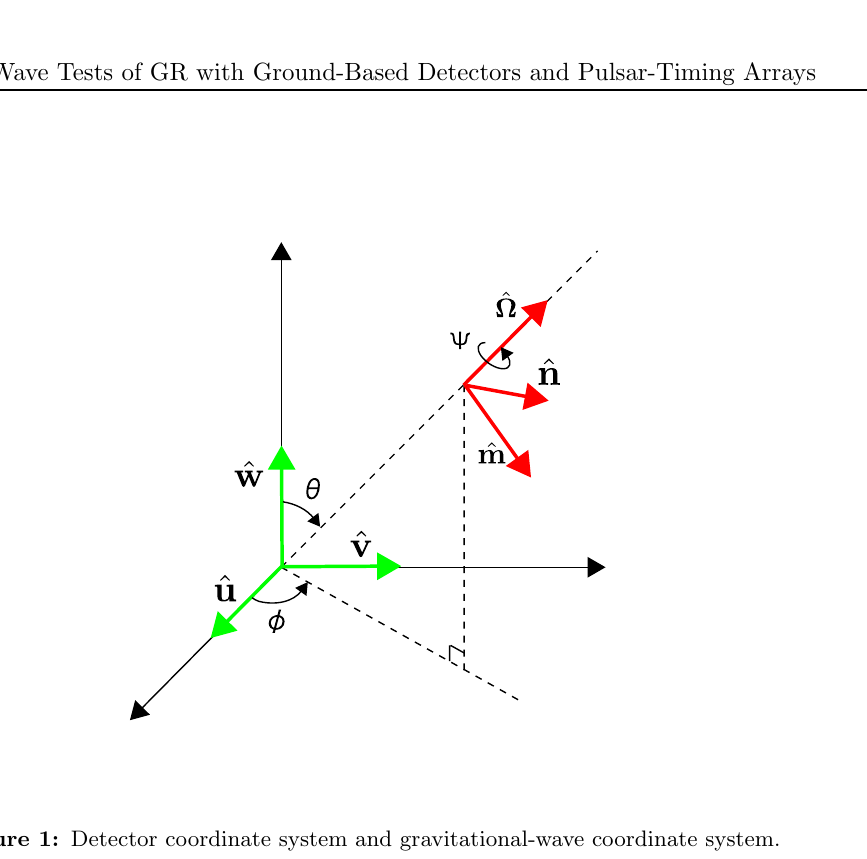
Figure 1: Detector coordinate system and gravitational-wave coordinate